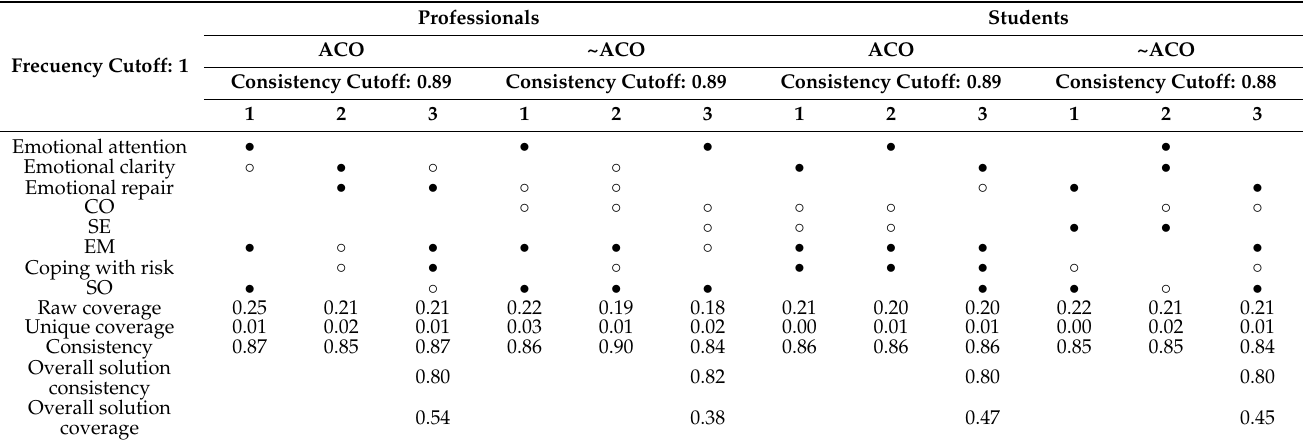
Table 5. Three main sufficient conditions for ACO and for absence of